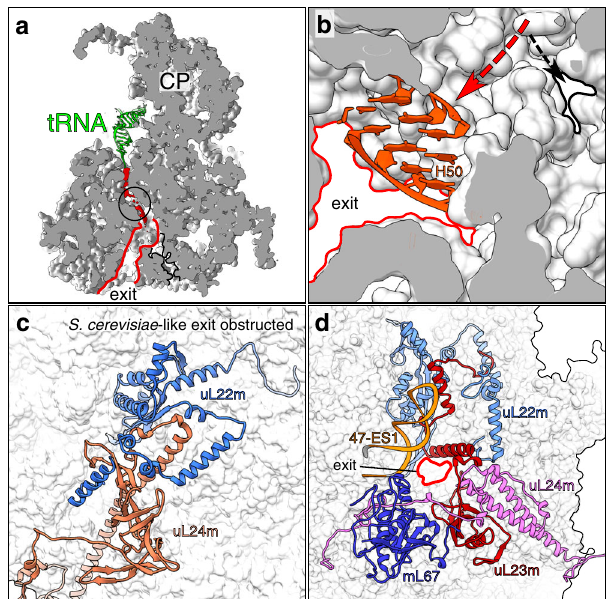
Fig. 4 The path of polypeptide of the mitoribosome from N. crassa . a Cross-section of the large subunit showing the tunnel with density of the polypeptide reaching from the PTC until the beginning of the lower part of the tunnel. The constriction site is shown by a black circle and the constricted tunnel is highlighted by a black outline. b View of the branching point from inside the tunnel. The red arrow shows the exit which was formed upon deletion of H50 (orange). The black arrow shows the path of the constricted tunnel. c S. cerevisiae -like exit site is sterically hindered by protein extensions of uL22m and uL24m, shown in cartoon. d The view of the exit site showing the surrounding proteins and